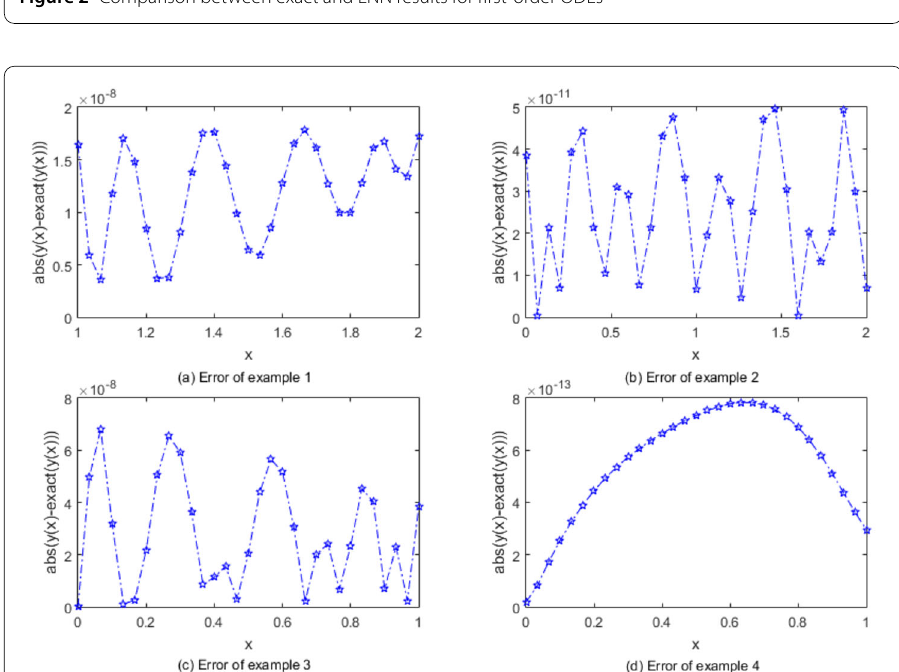
Figure 2 Comparison between exact and LNN results for first-order ODEs